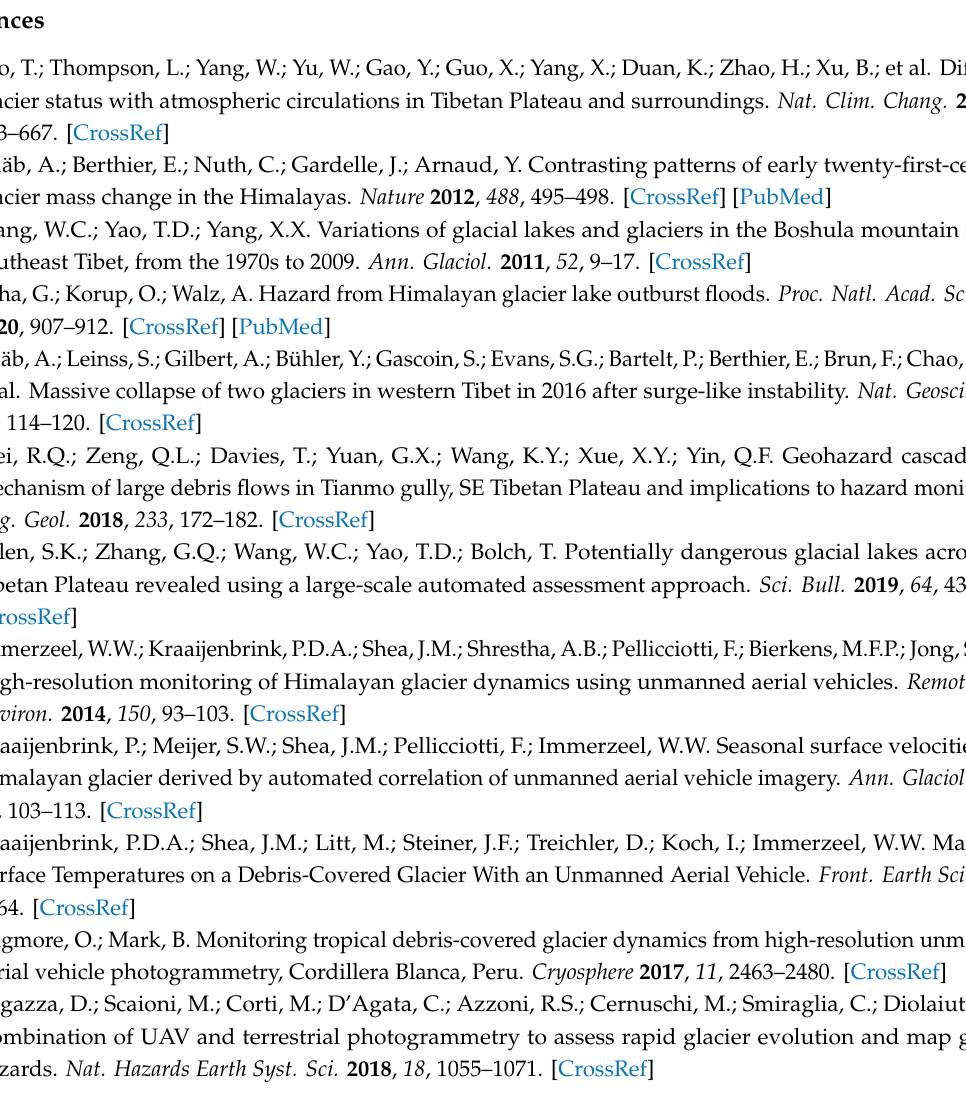
Figure A1. Three UAV-derived orthomosaics on 23 September 2018, 7 June 2019 and 7 October 2019 (from left to right) on the Parlung No. 4 Glacier.